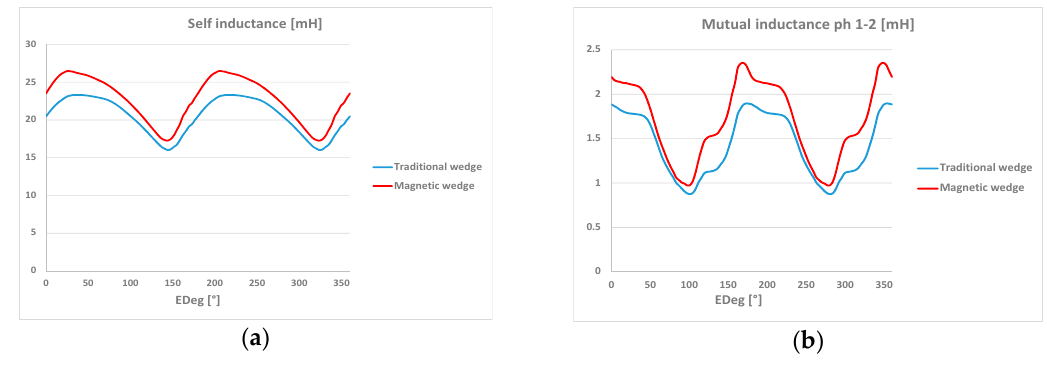
Figure 14. ( a ) Self-inductance of phase 1 at full load; ( b ) Absolute value of mutual inductance between